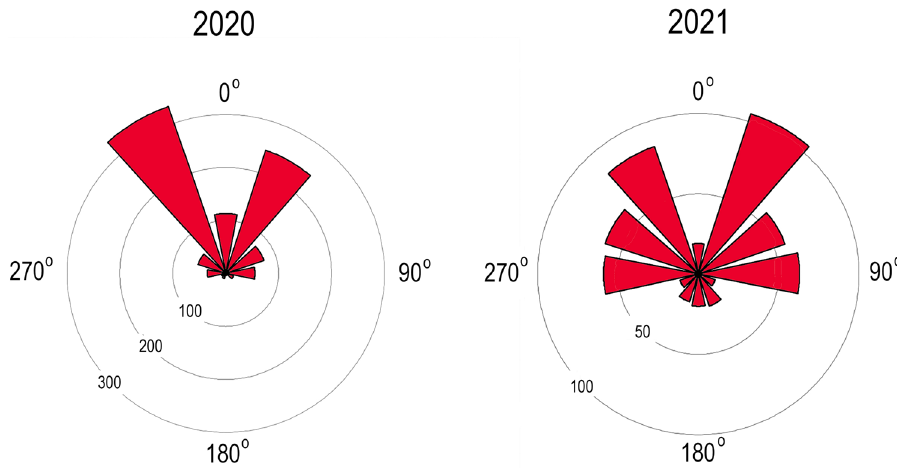
Figure 4. Location of corolla piercings in 2020 (mean angle = 359.7°; median angle = 0°) and 2021 (mean angle = 3.8°; median angle = 30°: calculated with circular package in RStudio). Bar width = 30°. Dorsal midline = 0°. Sample size indicated on radial